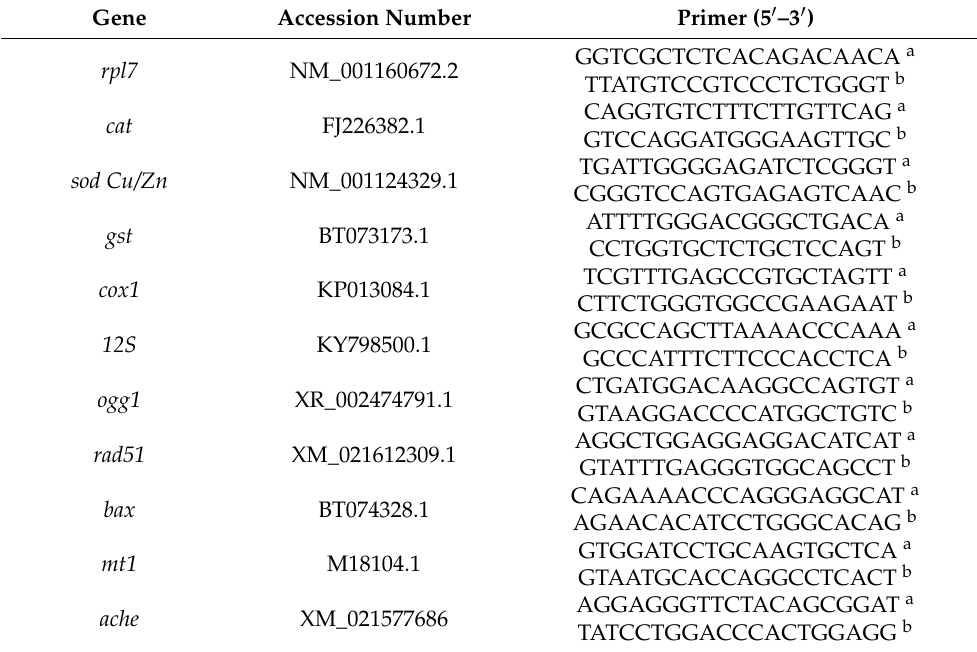
Table 1. Accession number and specific primer pairs for the Oncorhynchus mykiss used in our study. Gene Accession